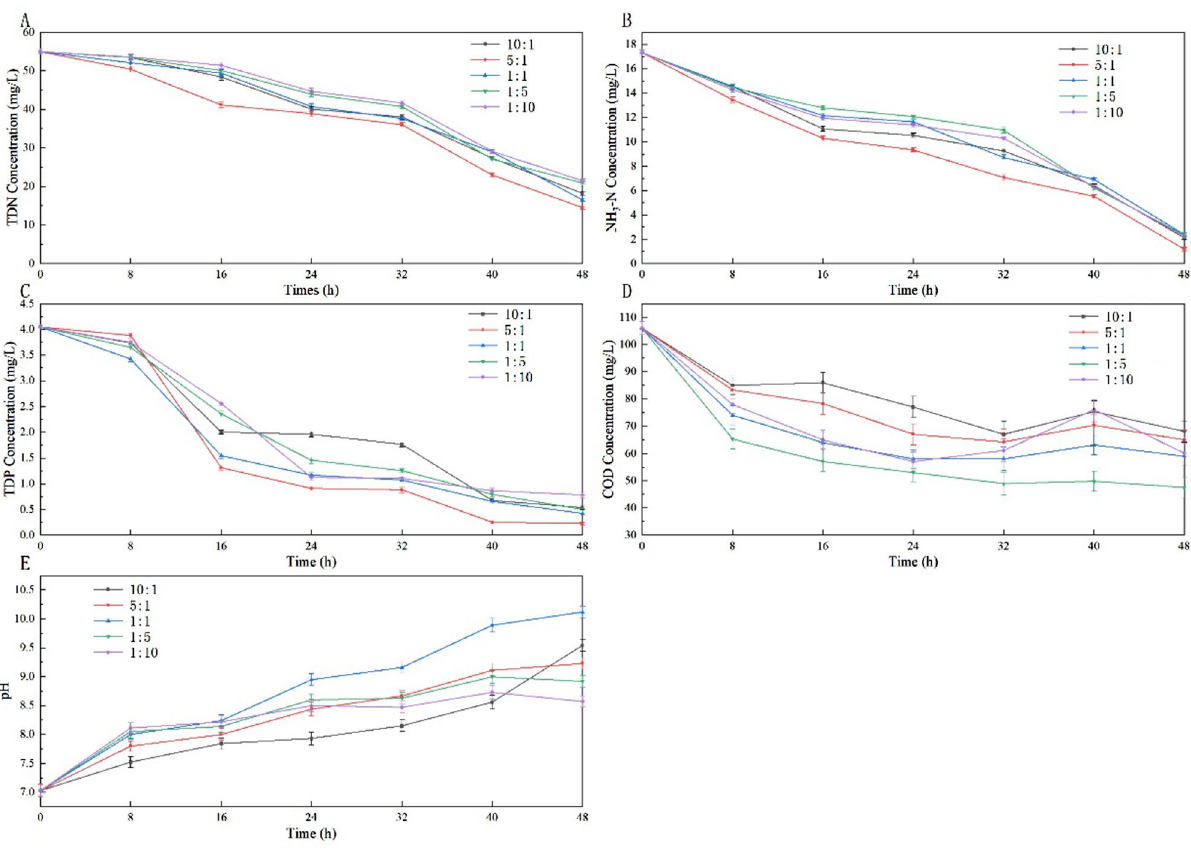
Figure 2. Concentration of water quality compositions in consortia. Consortia with algae/sludge 10:1, 5:1, 1:1, 1:5 and 1:10 (donated as R1 to R5). Nutrient and COD in different ratio of algal–bacterial consortia. And the pH in water. Ammonia nitrogen, total nitrogen, total phosphorus, COD, pH were shown in ( A ), ( B ), ( C ), ( E ) and ( F ) respectively.